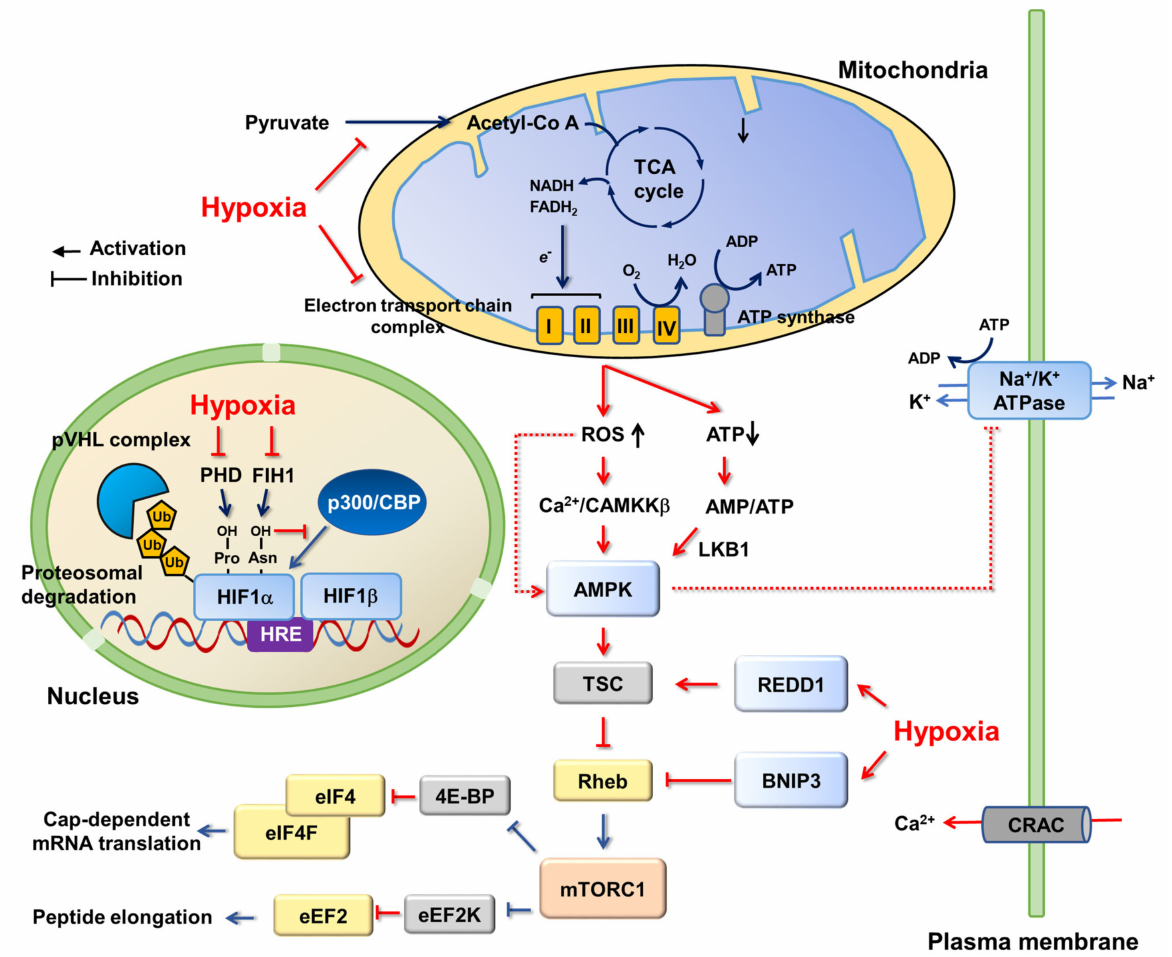
Figure 3. AMPK, mTORC1, and HIF1 in hypoxia. Hypoxia inhibits the mitochondrial electron transport chain complex to impair ATP synthesis. It can cause increases in intracellular ROS level, which increases intracellular Ca 2+ to activate AMPK, independent of any AMP/ATP change. When hypoxia lasts hours, intracellular AMP/ATP level is increased, which further enhances or maintains AMPK activation. AMPK inhibits mTORC1 via TSC, which is also directly activated by hypoxia through REDD1. In addition, hypoxia-induced BNIP3 disrupts Rheb-mTORC1 interaction, thereby leading to mTORC1 inhibition. Inactivation of mTORC1 in hypoxia causes the deceleration of protein translation at both initiation (by inhibiting eIF4F mRNA cap-binding complex) and elongation (by activating eEF2 kinase, a negative regulator of elongation factor eEF2) steps. Additionally, hypoxia stabilizes a heterodimeric transcription factor HIF by inhibiting HIF α proline hydroxylase PHD, which prevents the interaction between HIF α and E3 ubiquitin ligase pVHL complex. Molecular pathways regulated by hypoxia are shown in